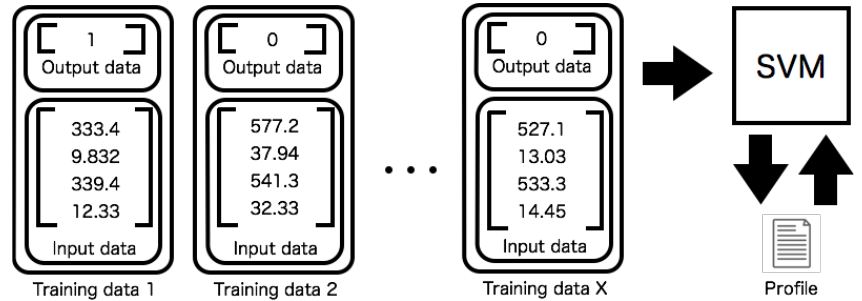
Figure 3. Training process of a profile between two sensors. The training data set are input to an SVM. The SVM learns desired outputs from the training data set.